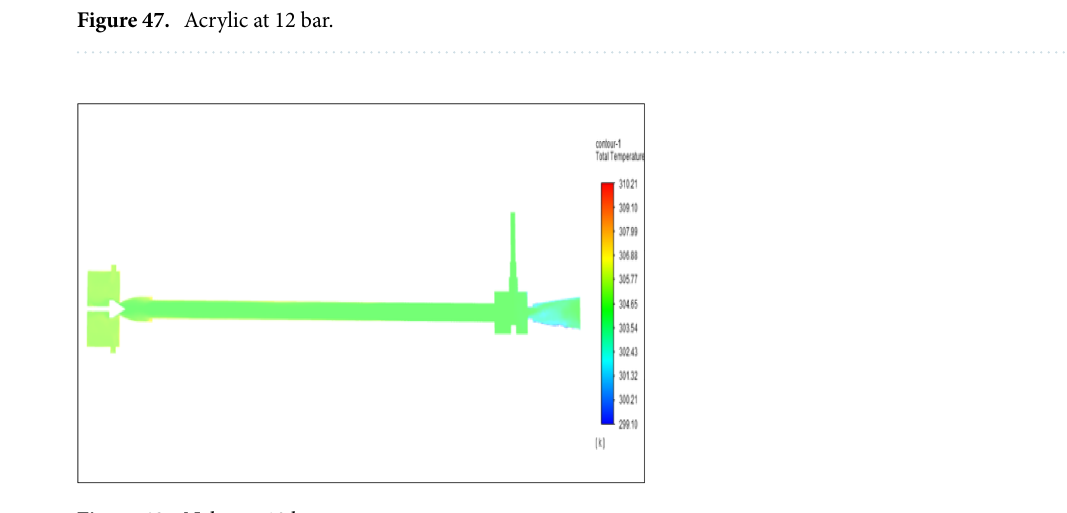
Figure 47 represents to acraulic vortex tube with an inlet pressure of 12 bars. The inlet temperature of the VT is 303 K. The hot air temperature was obtained at the hot end as 310.02 K. Similarly at the cold end side obtained a value of temperature as 298.78 K. The maximum temperature difference was found to be 11.12 K. Figure 48 represents to nylon vortex tube with an inlet pressure of 12 bars. The inlet temperature of the VT